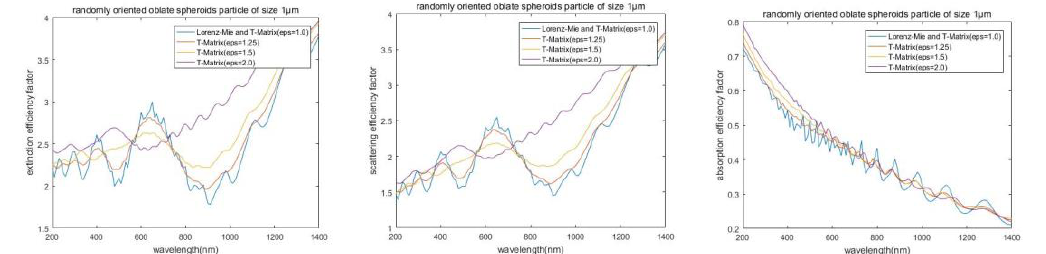
Figure 6. Comparison of extinction efficiency factor (left), scattering efficiency factor (middle) and absorption efficiency factor (right) of randomly oriented spheroids by T-matrix method and Lorenz-Mie theory with different wavelengths and shapes (refractive index is 1.55+0.01i, particle size is 1 micron)